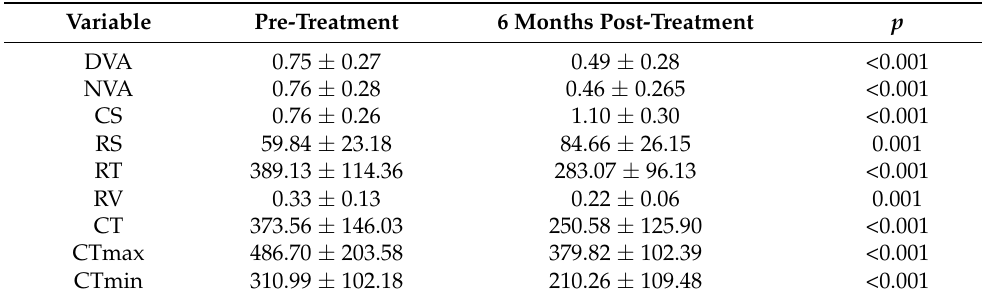
Table 2. Evaluation of visual and retinal morphology parameters between pre-treatment